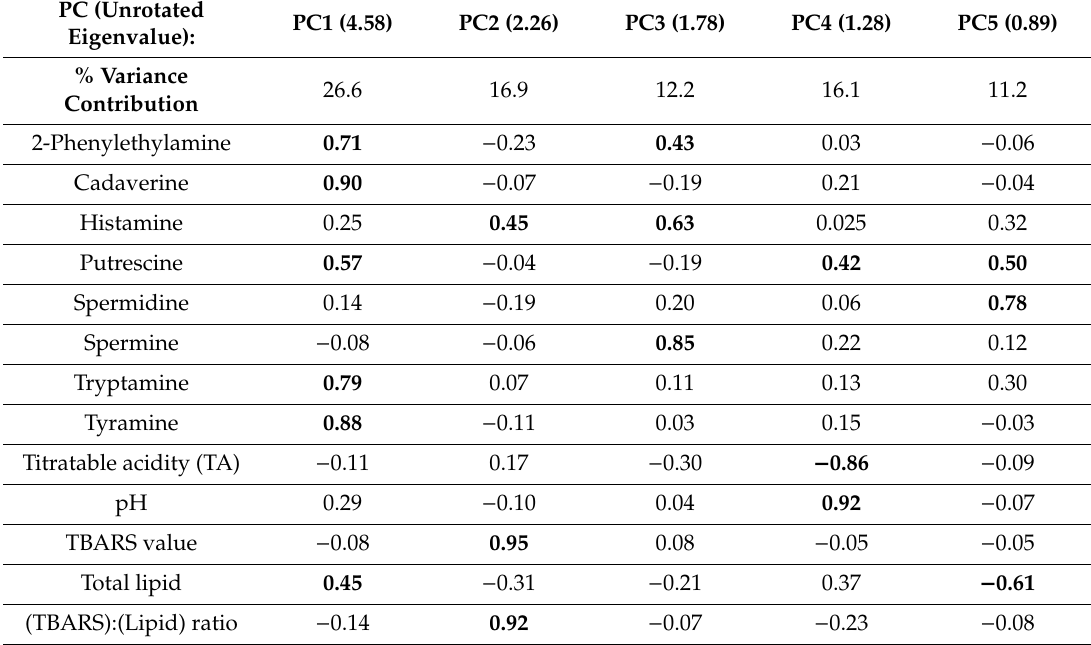
Table 4. PCA loadings vectors for BAs and additional fermented food analyte parameters (including total lipid contents, and pH and TA values) for a 5 PC-limited model performed with varimax rotation and Kaiser normalization. Percentage variance contributions for PCs 1–5 and their (unrotated) analysis eigenvalues are also listed. Bold numbers are for a purpose specified in the Figure